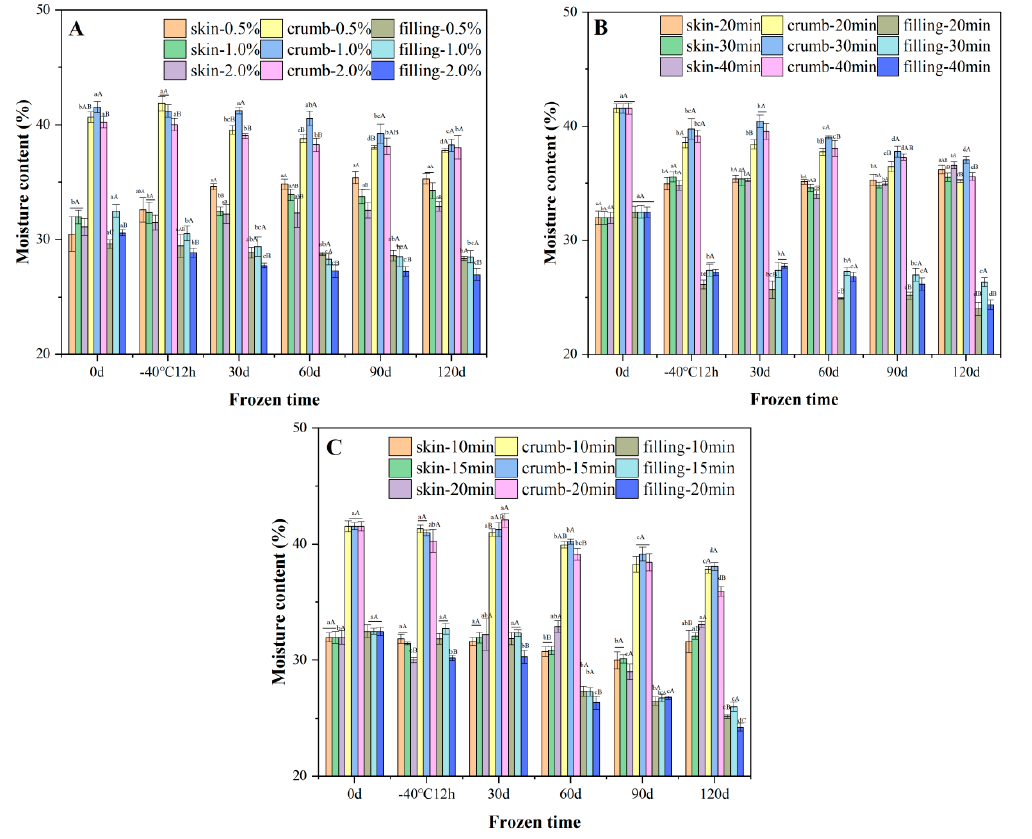
Figure 2. Effects of frozen storage on the moisture content distribution of steamed buns made from unfermented ( A ), pre-fermented ( B ) and par-steamed ( C ) dough. Data with different lowercase and uppercase letters indicate the significant differences among the frozen doughs with different storage times and different processing variables, respectively ( p < 0.05).